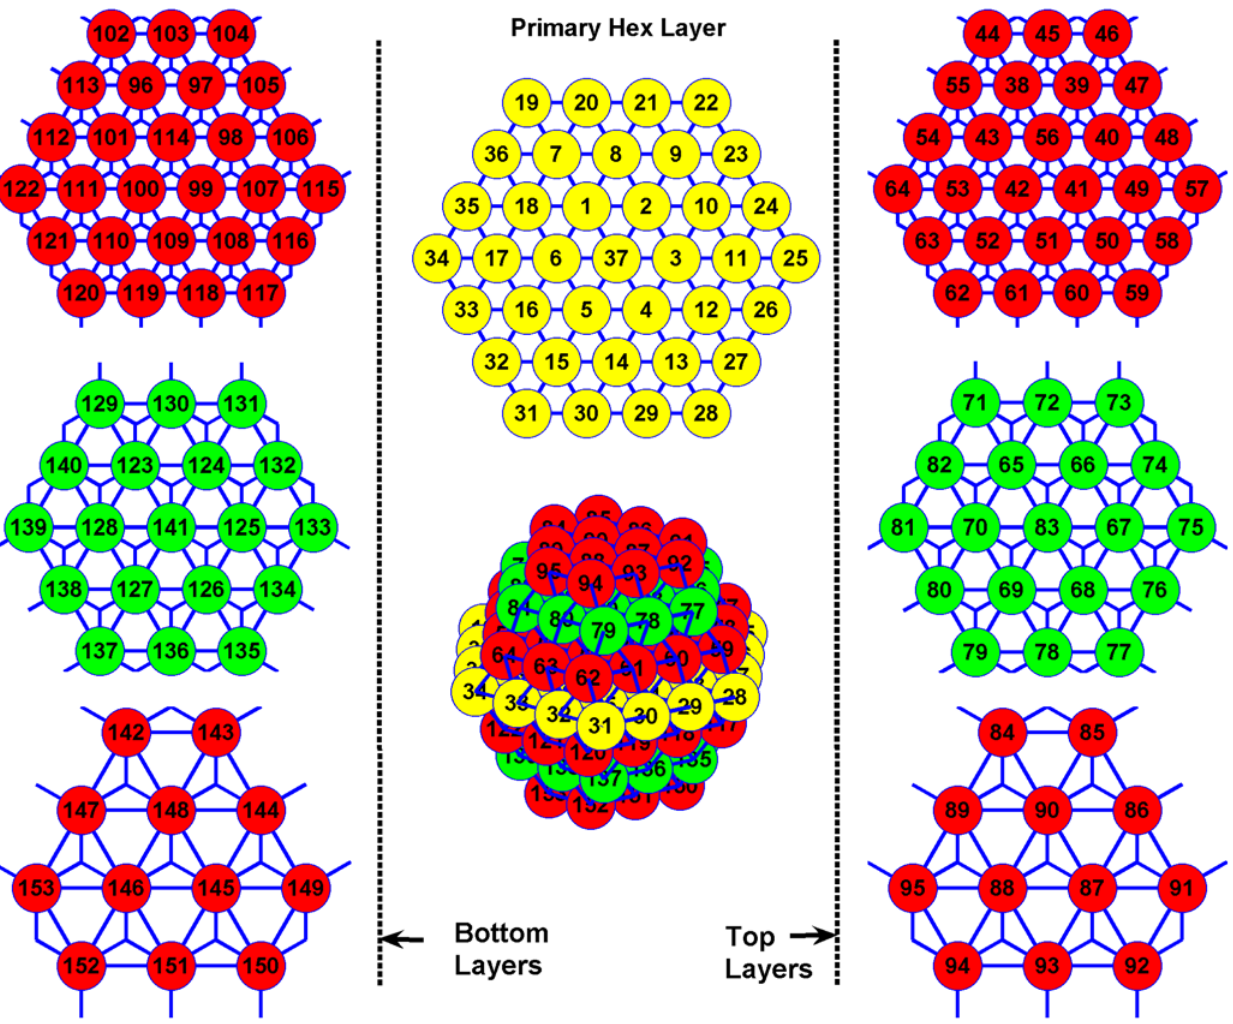
Figure 1. Cell labeling in a HCP cluster of n=4.